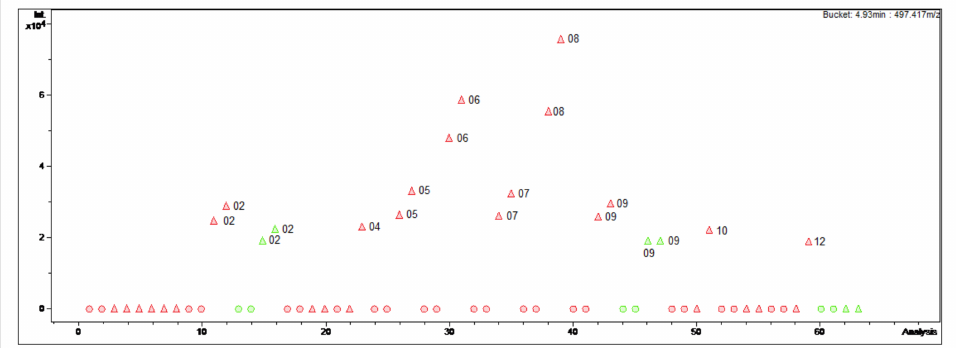
Figure 1. Bucket Statistic of O -tigloylcyclovirobuxeine-B (( 1 ); 4.93 min: 497.417 m/z ) in ProfileAnalysis 2.1. Legend: round dots = B . sempervirens var. suffruticosa ; triangle = B . sempervirens var. arborescens ; red = leaf; green = twig; number = month.